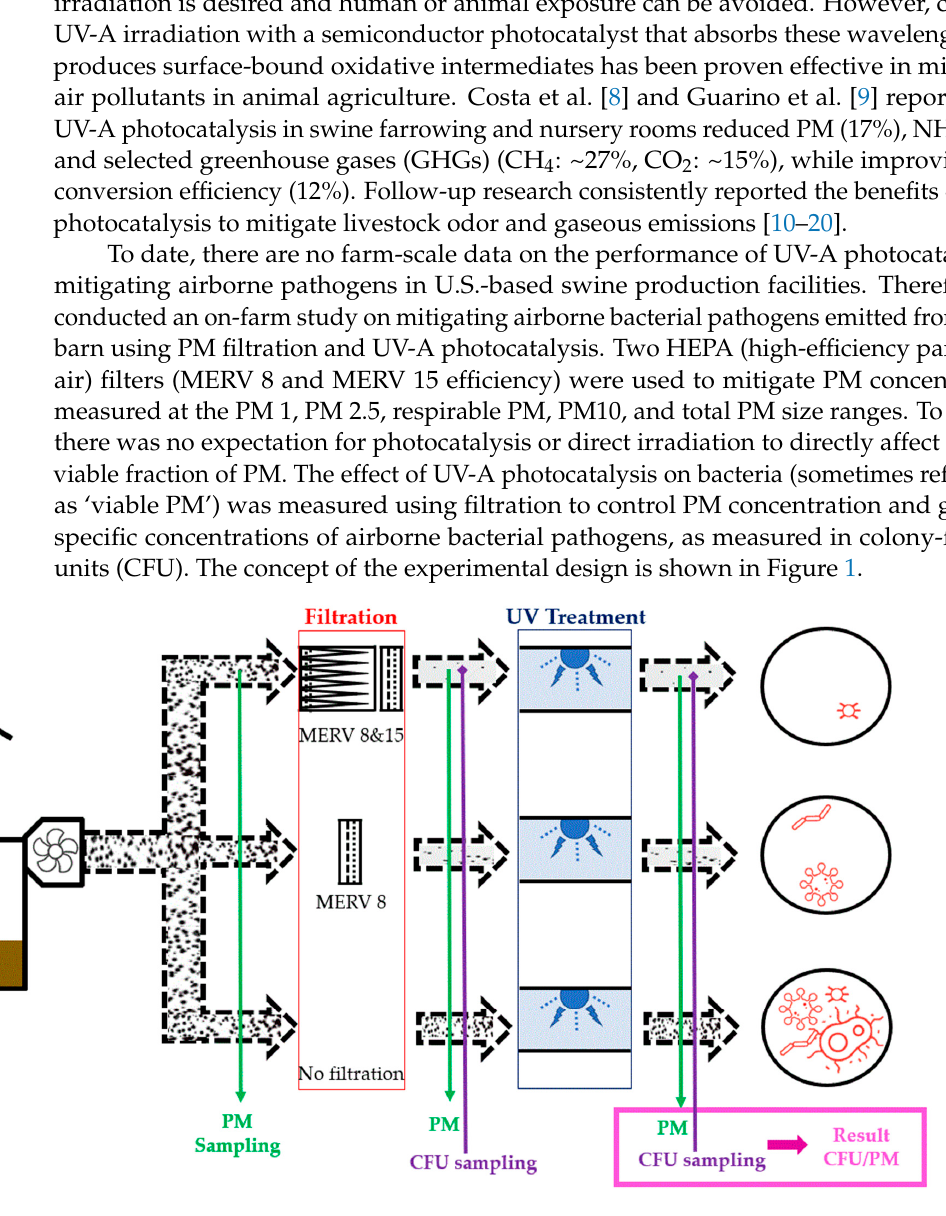
Figure 1. Mitigation of particulate matter (PM) and airborne pathogens in swine barn emissions with filtration and UV-A photocatalysis. Overview of experimental design and reporting of the mitigation effect. The UV-A treatment was performed under three PM loads: the ‘best-case’ (MERV 8 and 15), ‘midpoint’ (MERV 8), and ‘worst-case’ (no filtration).